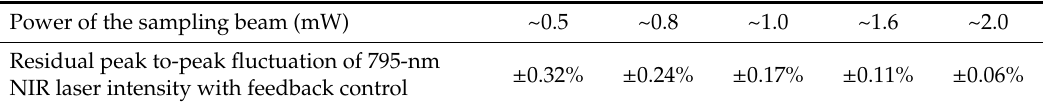
Table 1. Residual peak-to-peak fluctuation of 795-nm NIR laser intensity with feedback control vs. optical power of the sampling beam.